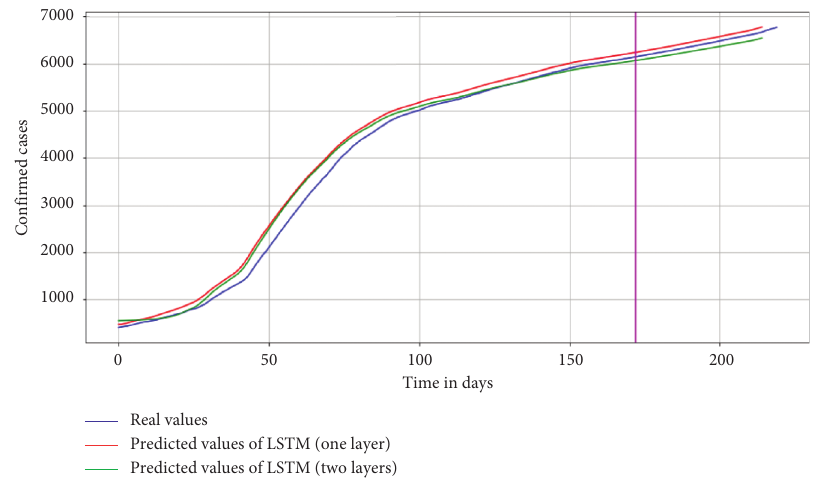
Figure 4: Comparison between real death cases and the predicted death cases for LSTM (Egypt).